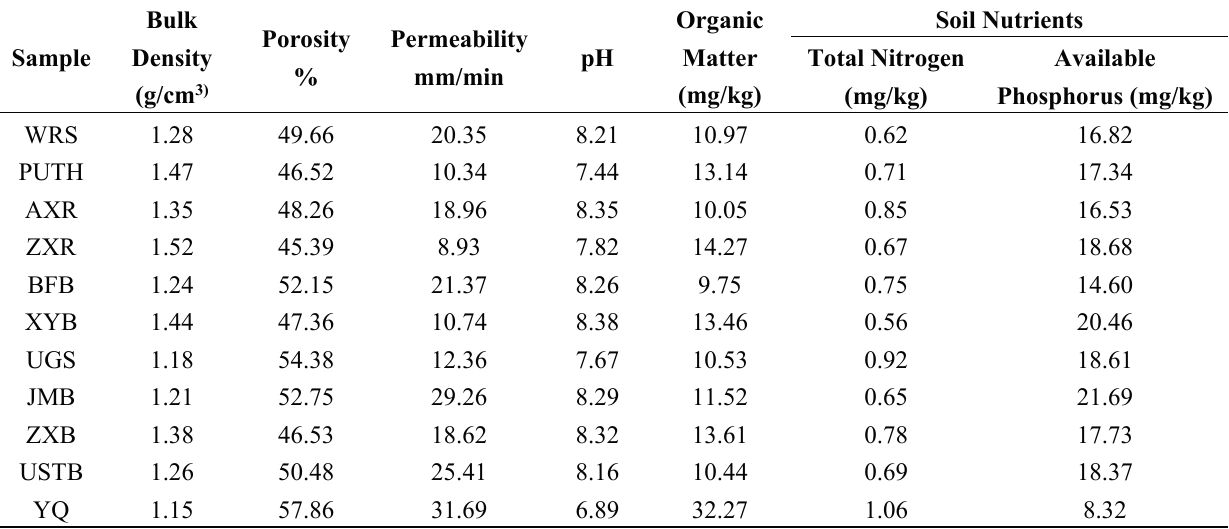
Table 1. Physical and chemical parameters in rural and urban soils of Beijing.